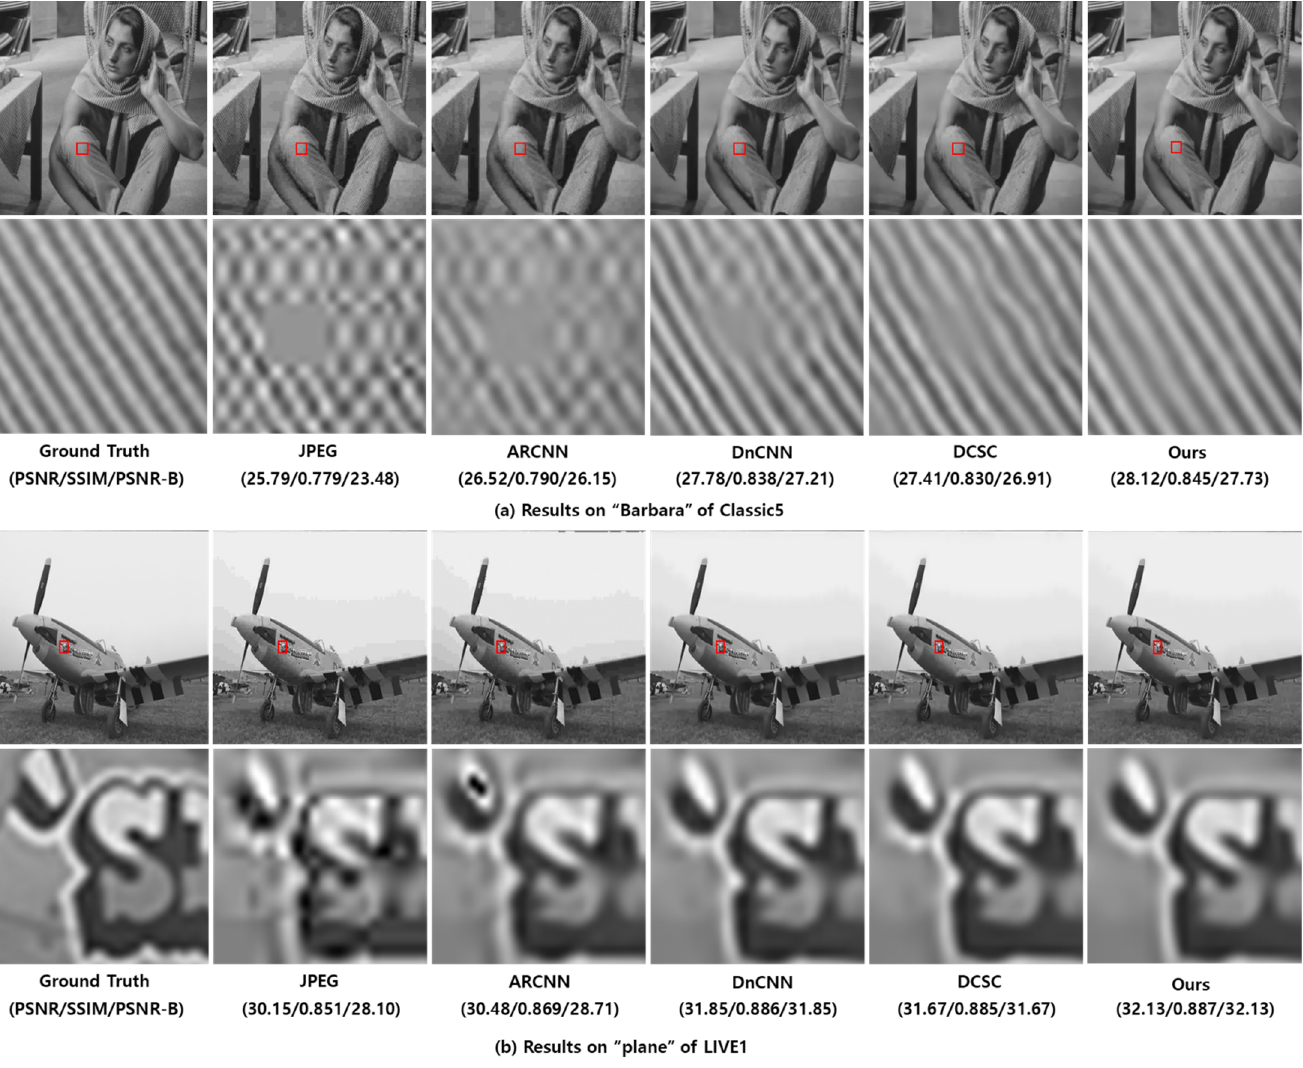
Figure 10. Visual comparisons on a JPEG compressed images where the figures of the second row represent the zoom-in for the area represented by the red box.